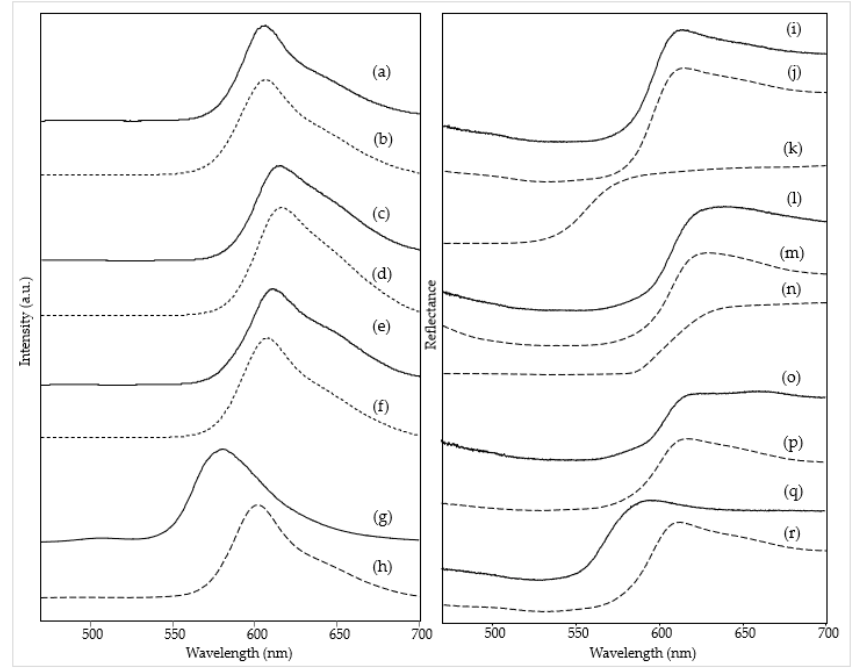
Figure 2. ( Left ) Emission spectra ( λ exc = 435 nm) of red areas: ( a ) The grammar of fire—Canto II , area 2, ( b ) reference sample of R371, ( c ) The North star and the tree of life , area 1, ( d ) reference sample of R435, ( e ) Earthquake , area 1, ( f ) reference sample of R376, ( g ) The North star and the tree of life , area 6 and (h) reference sample of O232. ( Right ) Visible reflectance spectra of red areas: ( i ) The grammar of fire—Canto II , area 2, ( j ) reference sample of R371, ( k ) reference sample of PO62, (l) The North star and the tree of life , area 1, ( m ) reference sample of R435, ( n ) reference sample of PR254, ( o ) Earthquake , area 1, ( p ) reference sample of R376, ( q ) The North star and the tree of life , area 6 and ( r ) reference sample of O232. Legend: (solid lines) spectra acquired on the paintings; (dashed lines) spectra of reference fluorescent paints or conventional pigments. Grey line black line